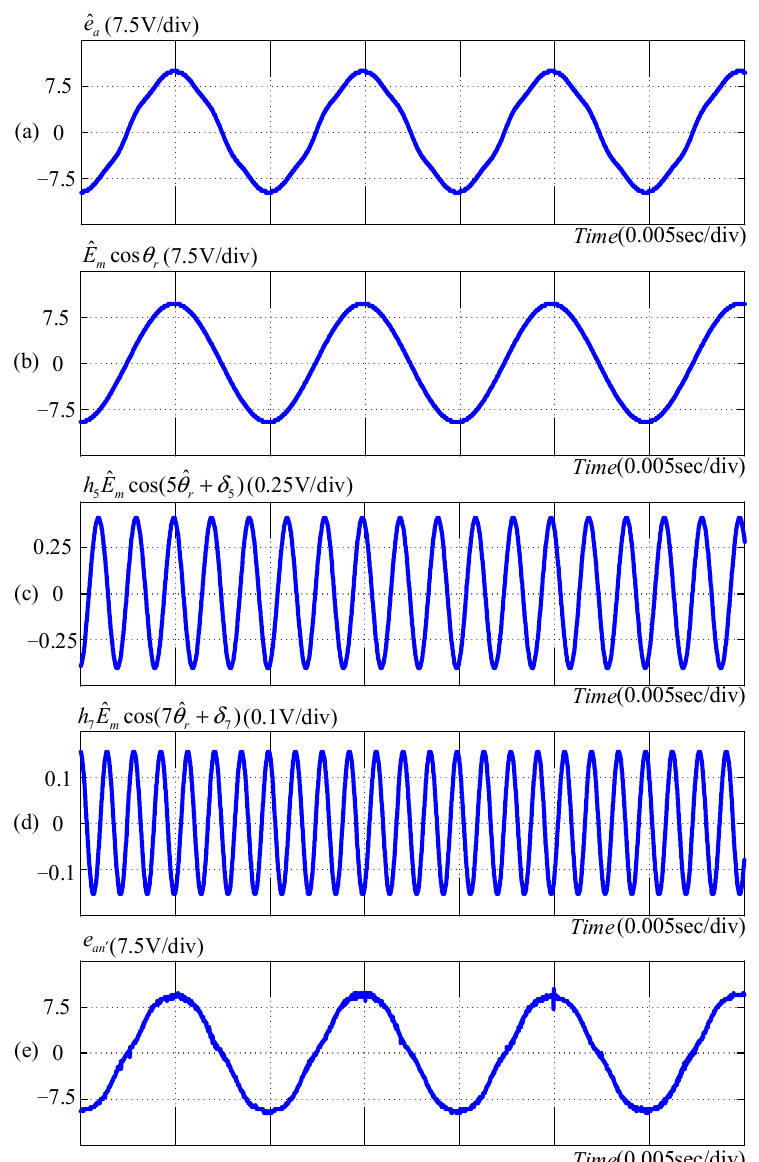
Figure 6. Figure 6 shows ˆ e r sixth harmonic component, whereas ˆ e r respective responses are the same as shown in Equations (11) and (12).